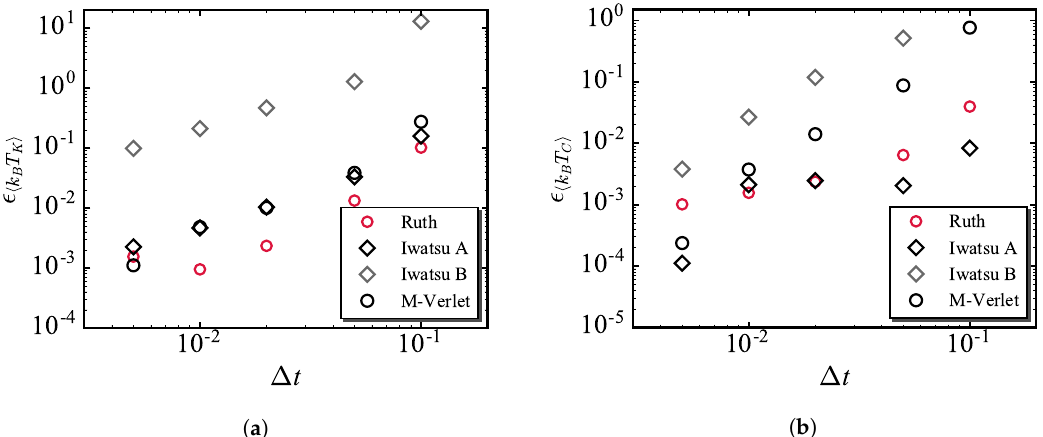
Figure 2. Errors in ( a ) ( k B T )